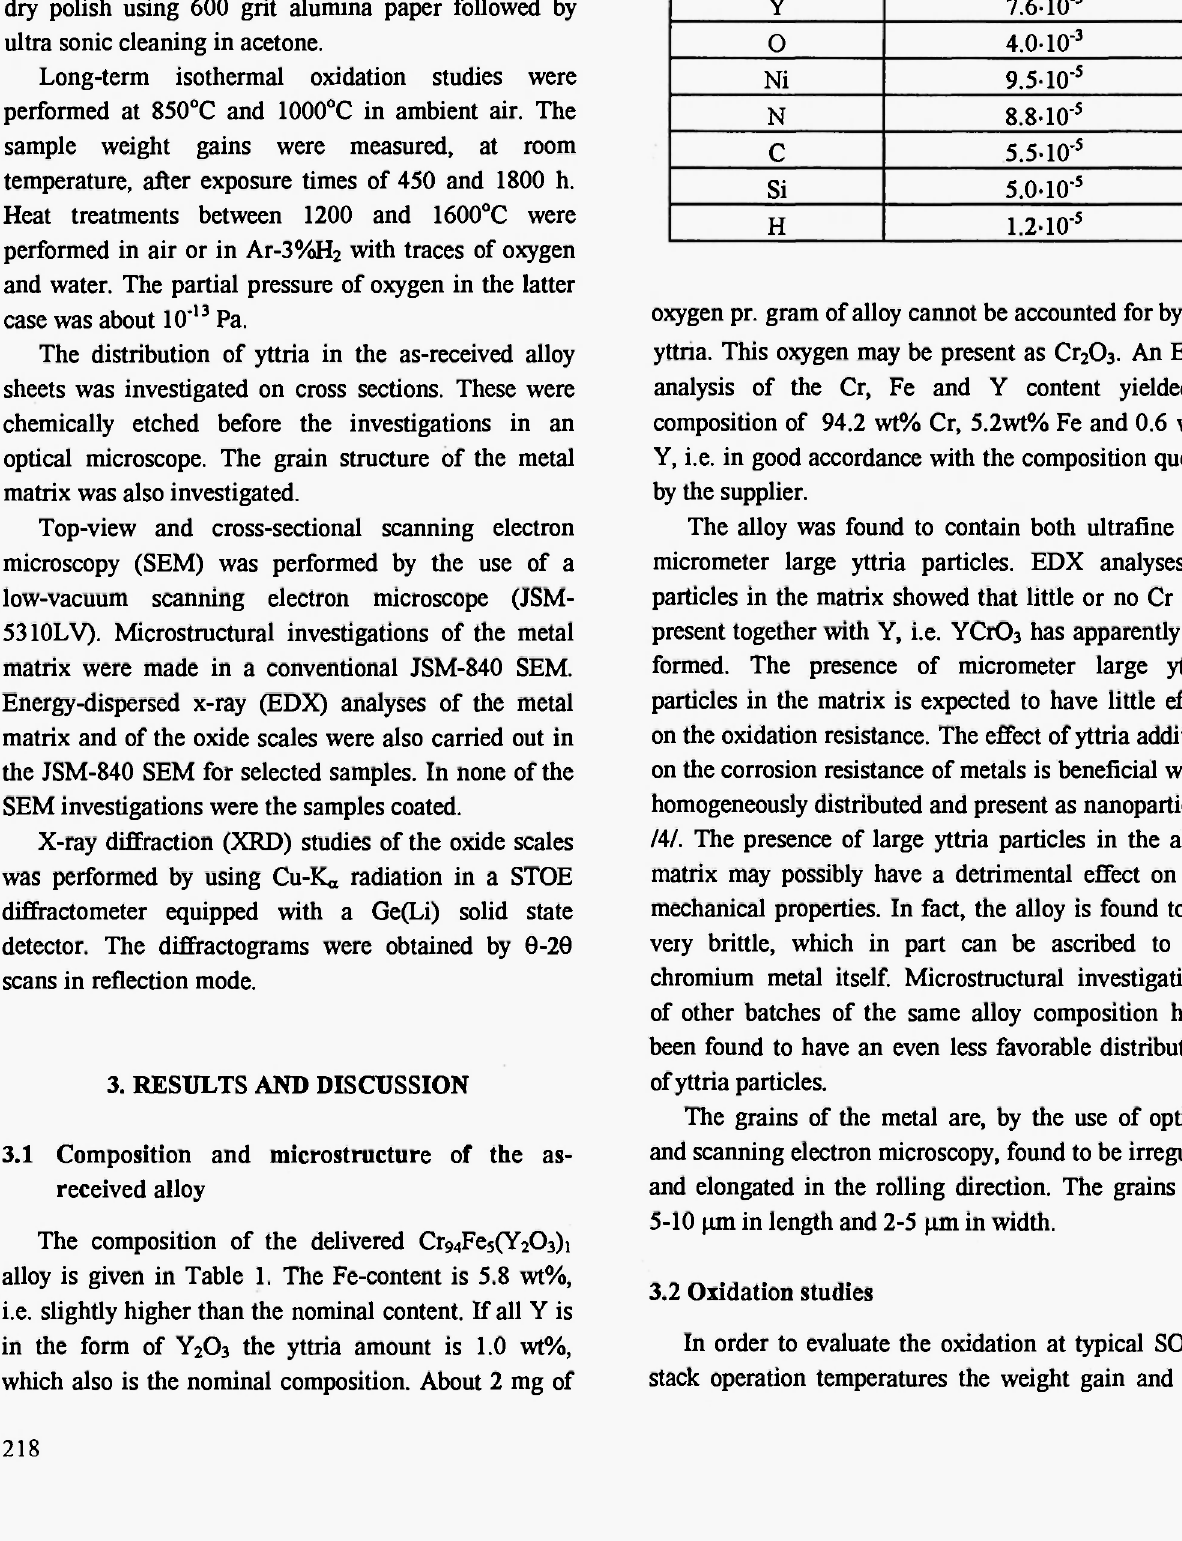
The composition of the as-delivered alloy. The composition has been supplied by Metallwerk